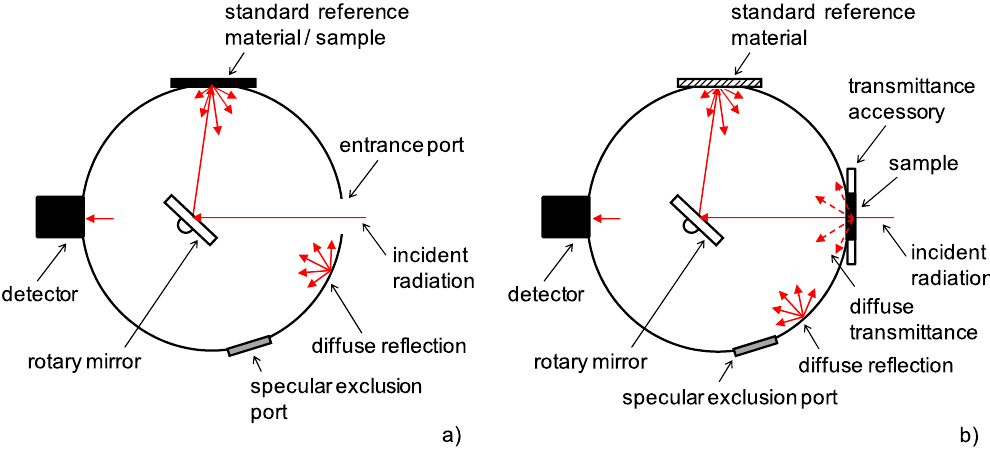
Figure 1. Schematic view of integrating sphere system. ( a ) Normal hemispherical reflectance measurement mode. ( b ) Normal hemispherical transmittance measurement